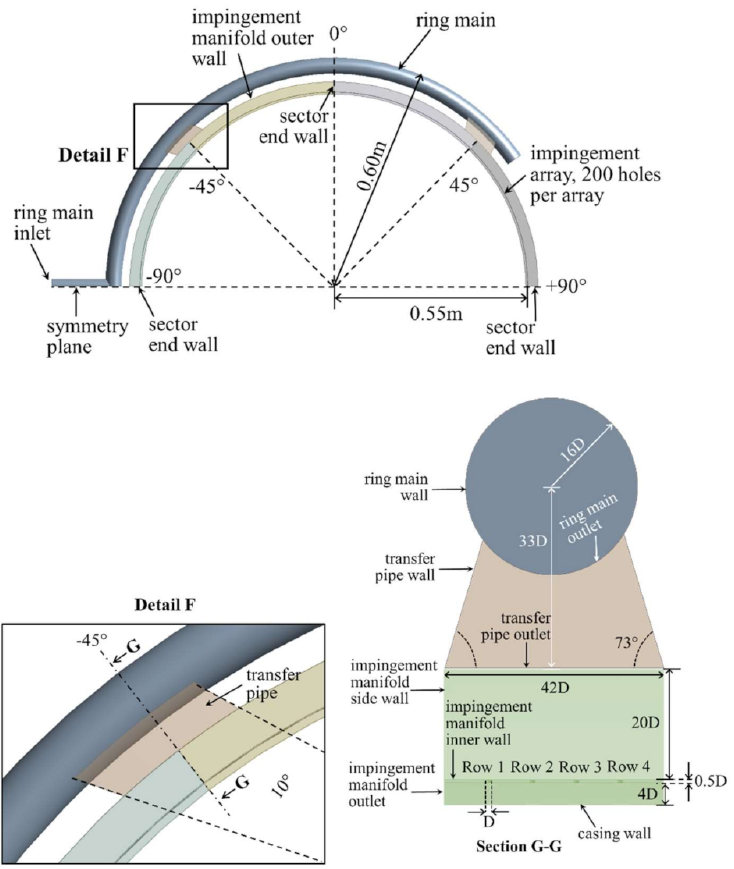
Figure 5. Multiple-entry ACC system geometry for CFD